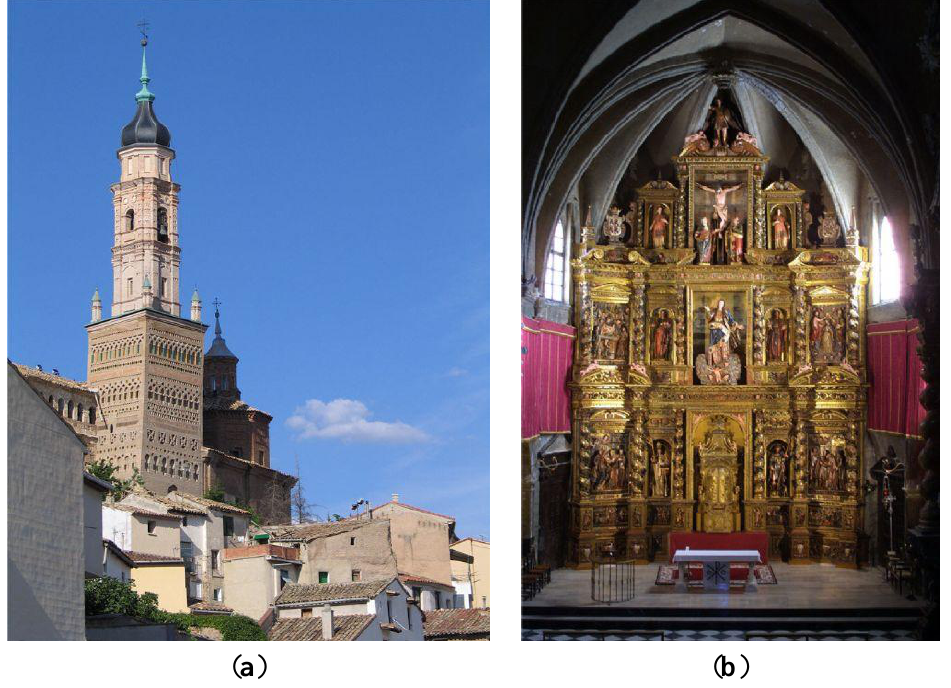
Figure 1. ( a ) Exterior Photograph of Mudejar Church of Santa María in Ateca. ( b ) Altarpiece. Photographs from the Prensa Diaria Aragonesa SA archive taken by Santiago